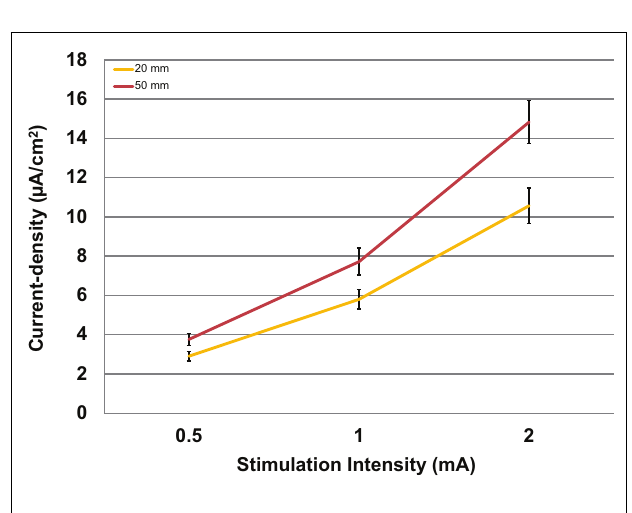
FIGURE 4 |Above are the mean current densities for the 50mm × 45mm electrodes and the 20mm round electrodes at the three current intensities 0.5, 1, and 2mA . Error bars represent ± standard error of the mean.